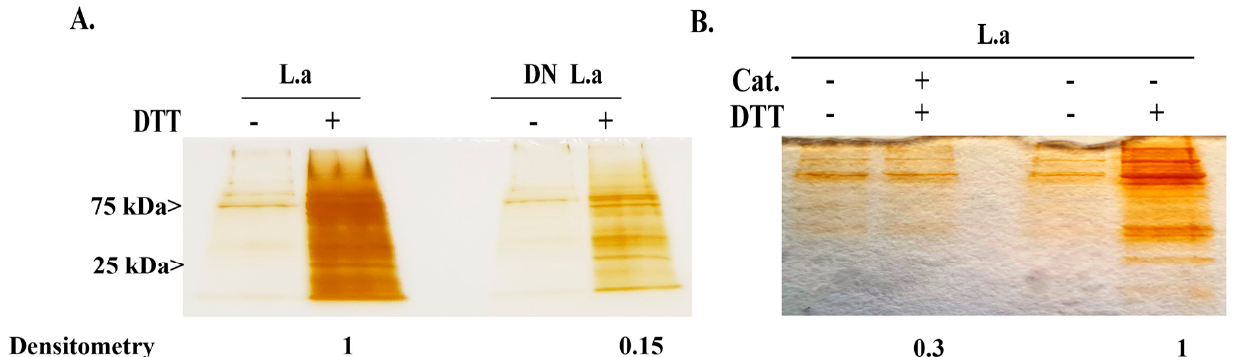
Figure 2. Detection of OXs by resin-assisted capture (OX–RAC) analysis of E. histolytica. Note: E. histolytica trophozoites were incubated with live L. acidophilus (L.a) or with heat-killed L. acidophilus (DN L.a) ( A ), with/without catalase (Cat.) (50 µ g/mL) ( B ) for 2 h at 37 ◦ C. Total protein lysate was prepared by lysing the trophozoites with 1% Igepal in PBS. The oxidized proteins in the cell lysates were subjected to RAC in the presence of 10 mM DTT (+DTT) or the absence of DTT ( − DTT). The protein was resolved on a 12% SDS-PAGE and stained with silver stain.